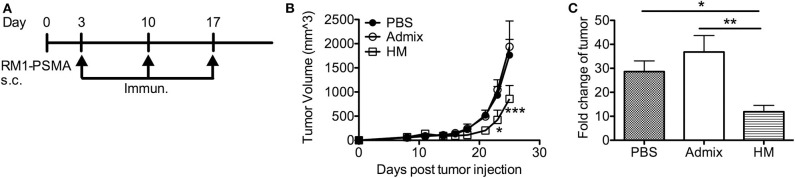
HM IS-SNAs delayed the tumor growth of RM1-PSMA. Mice (3–5 mice per group) inoculated subcutaneously with 105 RM1-PSMA tumor cells were immunized with admix, HM IS-SNAs containing PSMA634−642 and CpG on day 3, 10, 17. (A) Treatment schedule for RM1-PSMA tumor bearing mice. (B) Tumor growth curve of RM1-PSMA bearing mice. ***p < 0.001 (day 25) for  vs ; *p < 0.05 (day 23) and ***p < 0.001 (day 25) for  vs , calculated by two-way ANOVA with bonferroni multiple comparisons post-test. (C) The fold change of tumor was calculated using tumor volume of last measurement divided by the 1st tumor measurement. *p < 0.05 and **p < 0.01, analyzed by two-tailed unpaired Student's t-test. All data are presented as mean ± SEM.